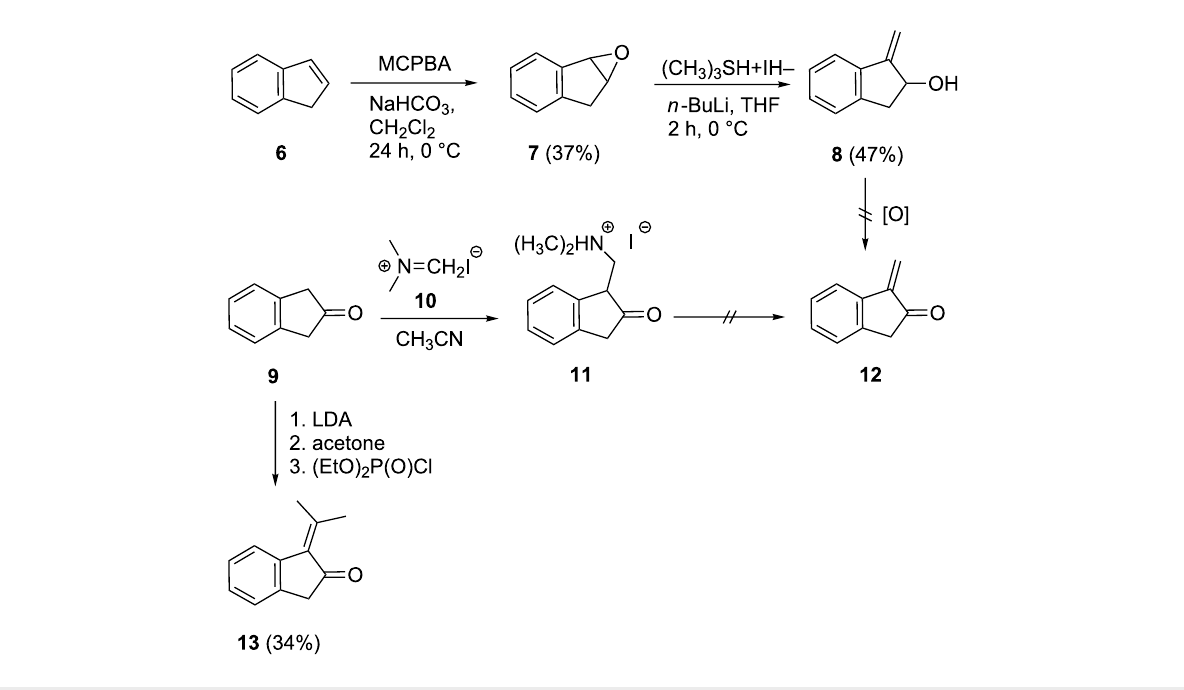
Scheme 2: Attempts to prepare the α -methylene ketones 12 and 13 .